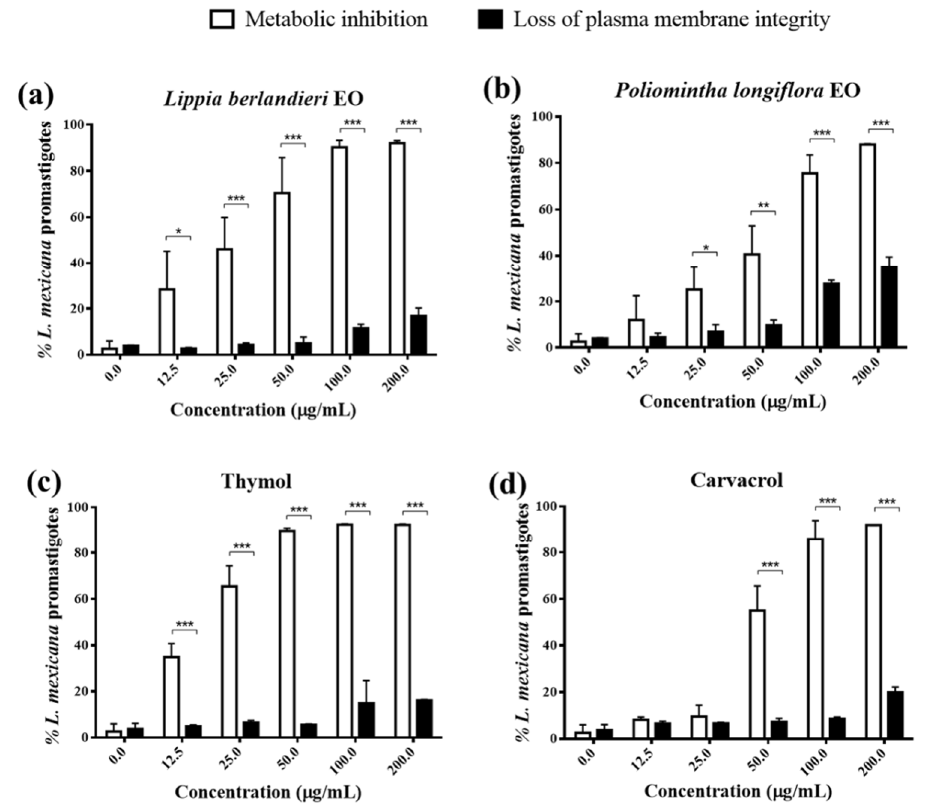
Figure 1. ( a ) Effect of Lippia berlandieri EO, ( b ) Poliomintha longiflora EO, ( c ) thymol, and ( d ) carvacrol on metabolic inhibition and loss of plasma cell membrane integrity of Leishmania mexicana promastig- otes. Parasites were treated with 0, 12.5, 25, 50, 100, and 200 µ g/mL of EOs or pure compounds and incubated for 24h. Each bar represents the mean ± standard deviation of three experiments ( n = 3). Statistical comparison was performed with two-way ANOVA (concentration x effect) with Sidak’s multiple comparison test, * p ≤ 0.05, ** p ≤ 0.01, and *** p ≤